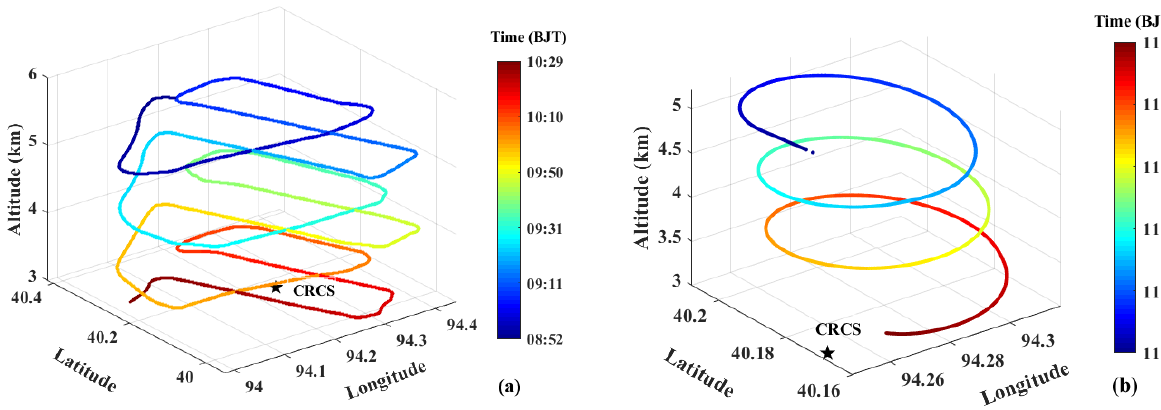
Figure 4. U- shaped flight pattern ( a ) and spiral descent flight pattern ( b ). The black asterisk represents the CRCS ground station.